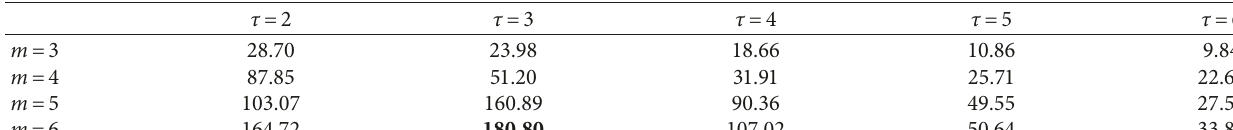
9.84; (b) m (cid:31)